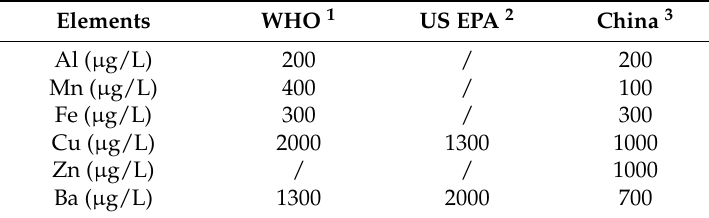
Table 2. Guideline values for heavy metals in drinking water.